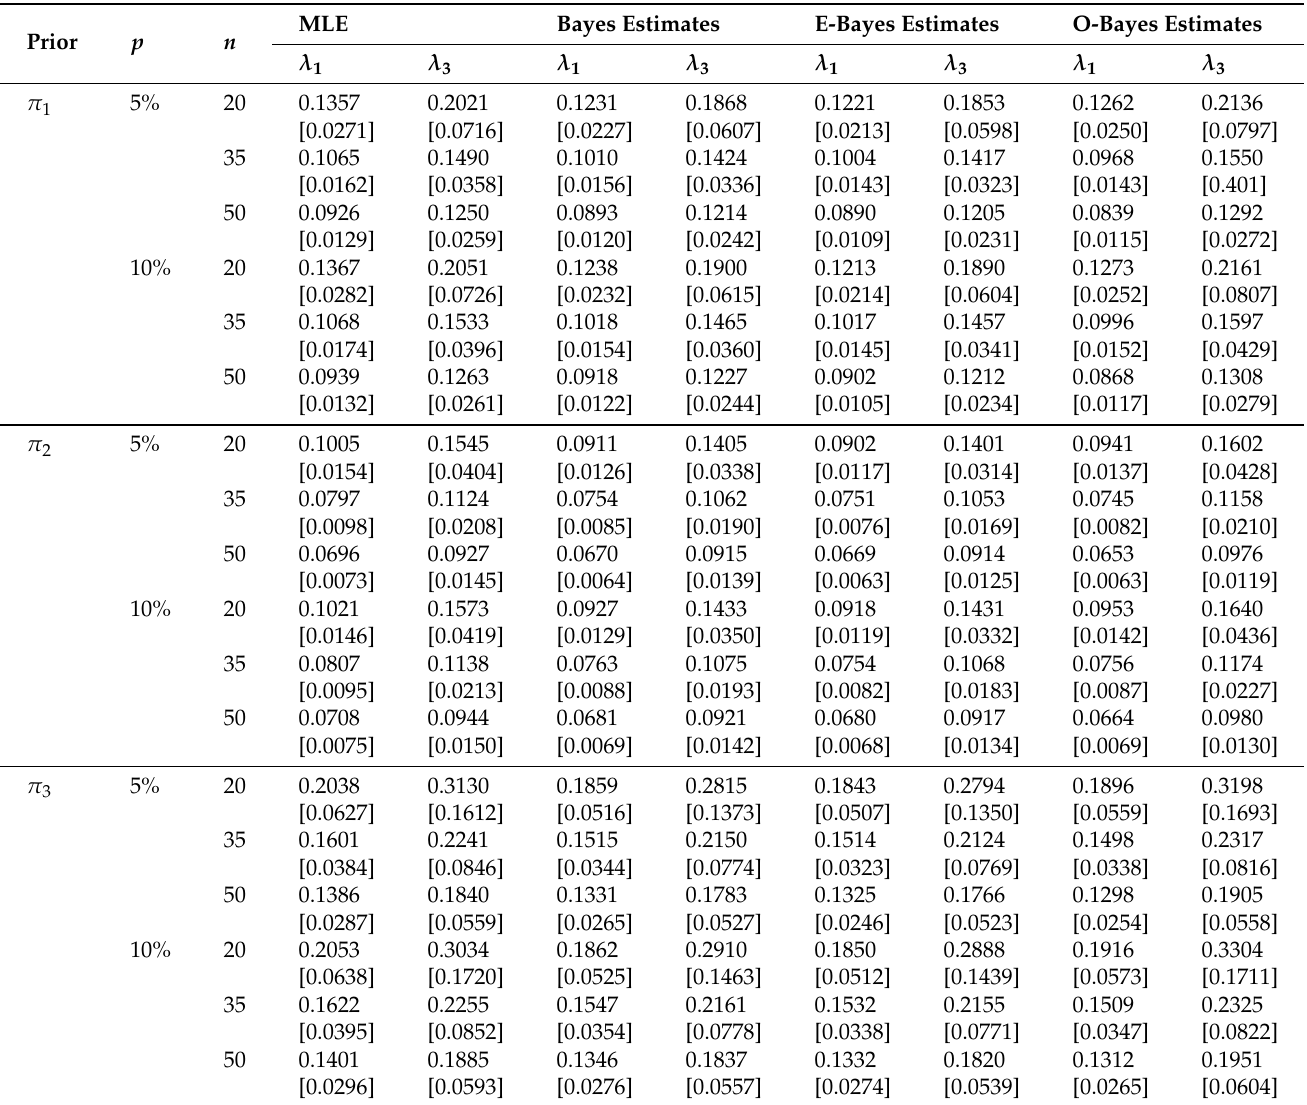
Table 1. ABs and MSEs (within bracket) for MOBE competing risks parameters with ( c 1 , c 2 , c 3 ) = ( 2,2.5,1.5 ) and τ = R